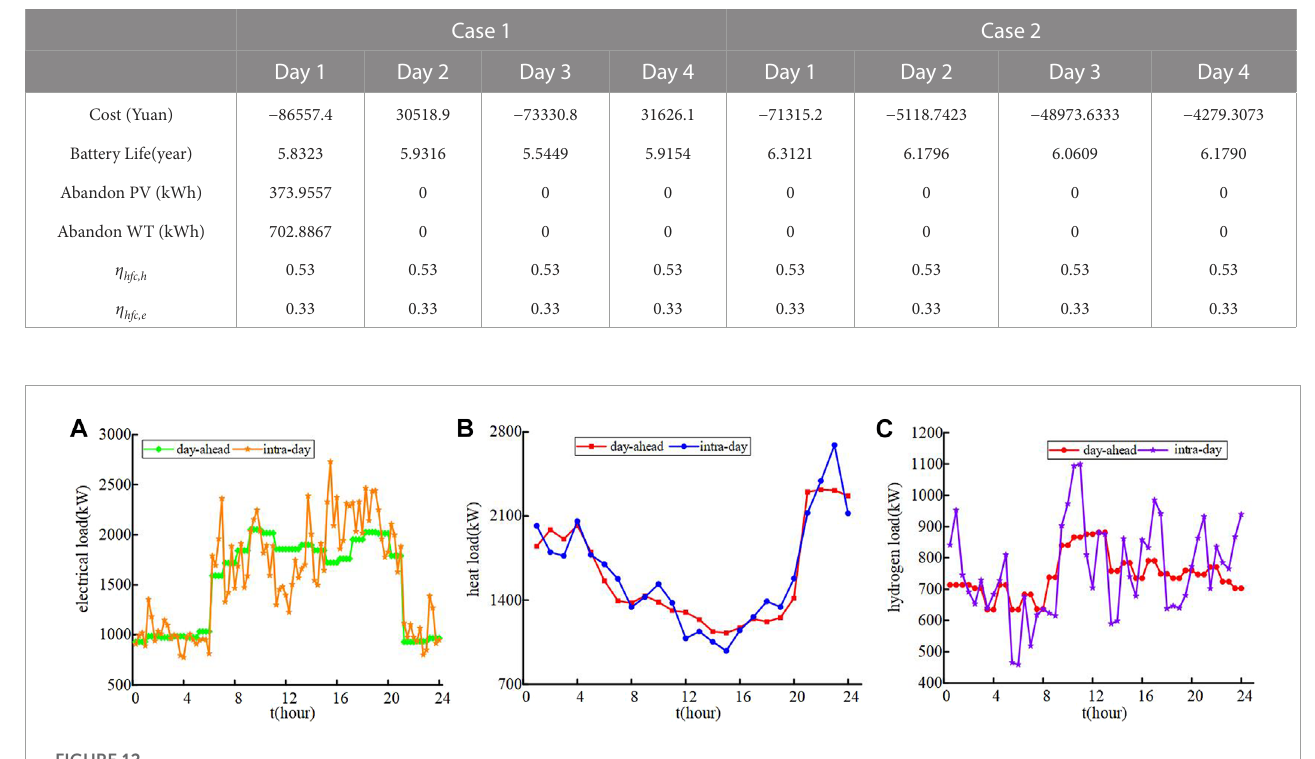
TABLE2 Optimizationresultsfortwocases.